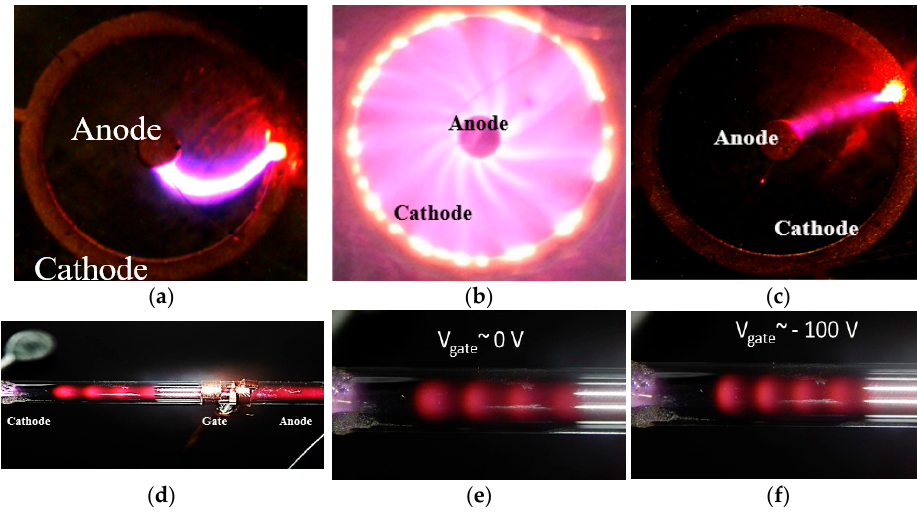
Figure 17. ( a ) A coaxial pin-ring structure with a plasma arc that is bent by applying a perpendicular magnetic field; ( b ) the same device with the plasma arc un-pinned and rotating around the ring in the presence of the external magnetic field [29,39]; ( c ) striations are observed in the ring devices; and ( d – f ) a linear extended plasma device with striations controlled using a gate electrode. The rings are around 1 cm in diameter. The linear device is 4 cm long.